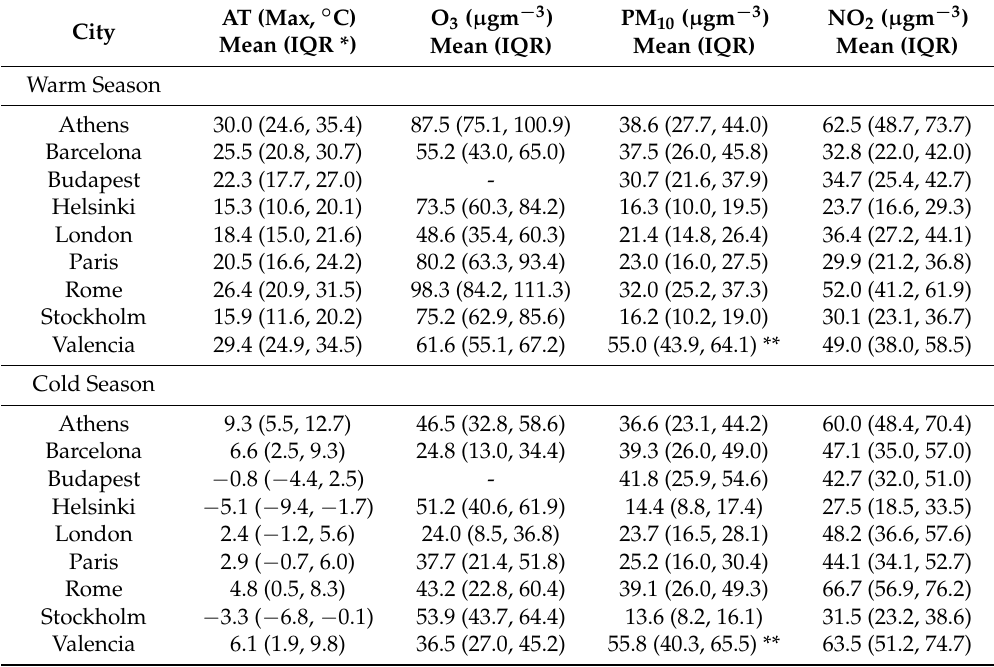
Table 2. Descriptive characteristics of maximum apparent temperature (AT) and pollutant variables in each participating